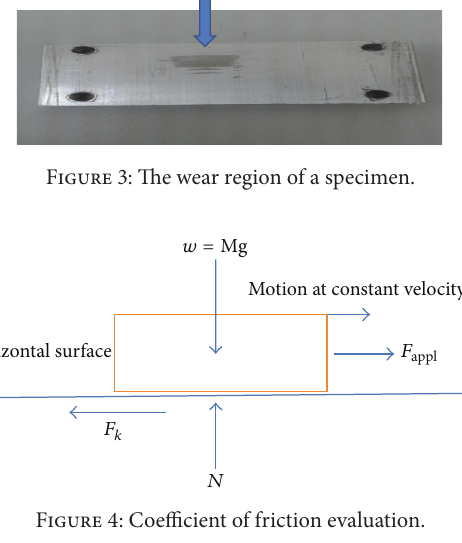
Table 2: Process parameter and its level.